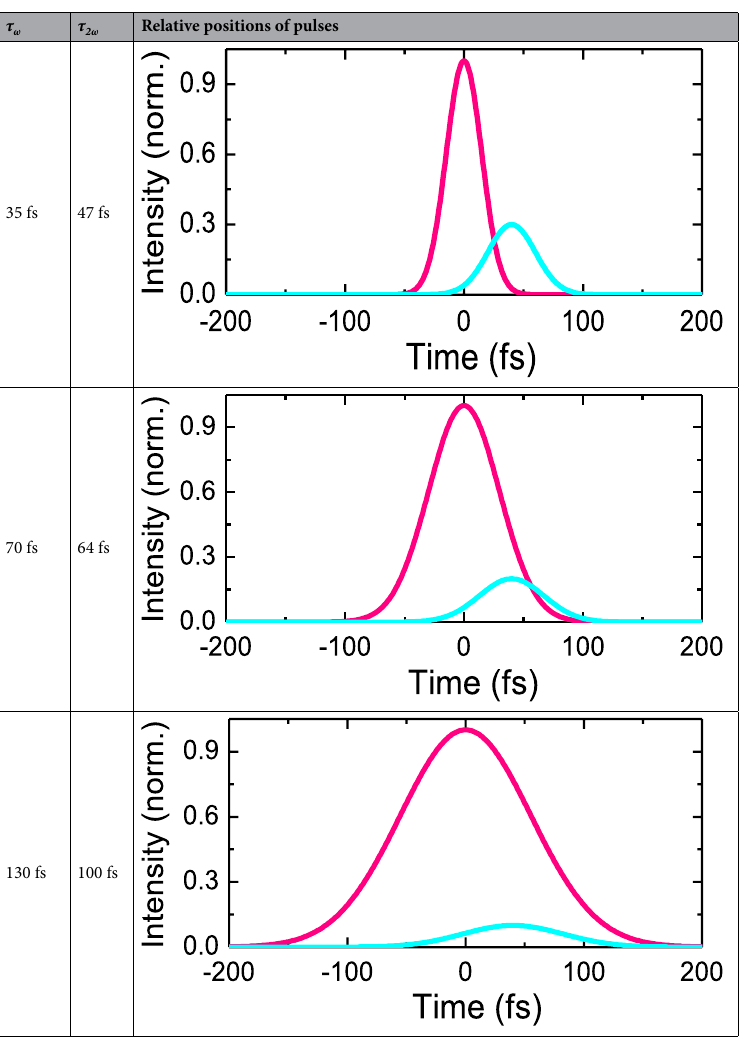
Table 1. The pulse durations of the fundamental pulse (800 nm), SH (400 nm), and relative positions of the fundamental (red curves) and SH (blue curves) pulses in the probing two-color pulse in the case of 0.2-mm thick BBO. The magnitude of the SH component is artificially increased for the visual comparison with regard to the fundamental